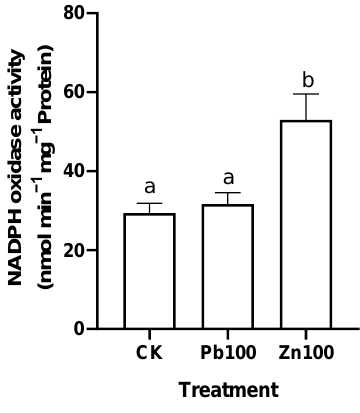
Figure 4. The determination of H 2 O 2 content ( a , b ) and O 2 − -producing rate ( c , d ) in roots of M. cordata grown hydroponically under control (CK) and varied concentrations of Pb and Zn for seven days. Values are means ± SE ( n = 3) with three separate replicates. Means denoted by different letters refer to the significant differences ( p < 0.05, Duncan’s test).